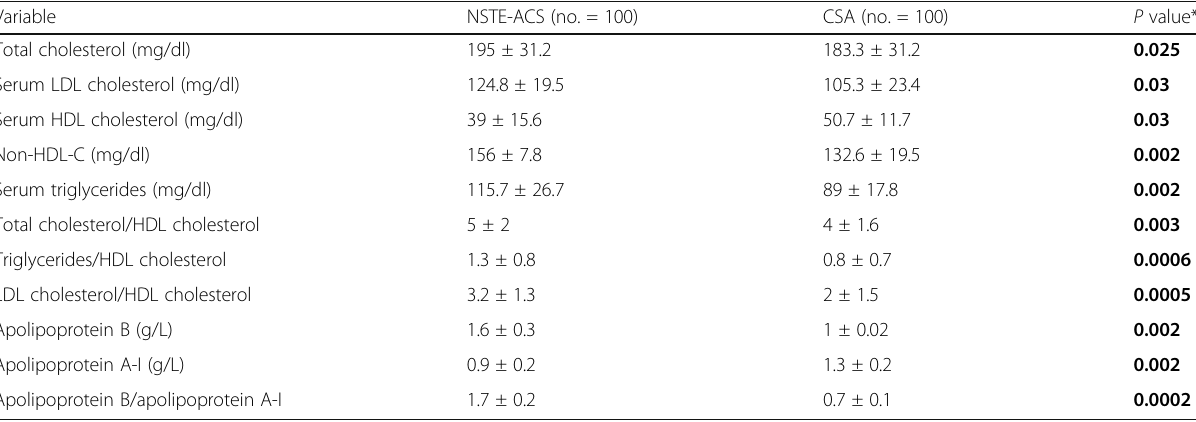
Table 2 Lipid profile indices of the two study groups Variable